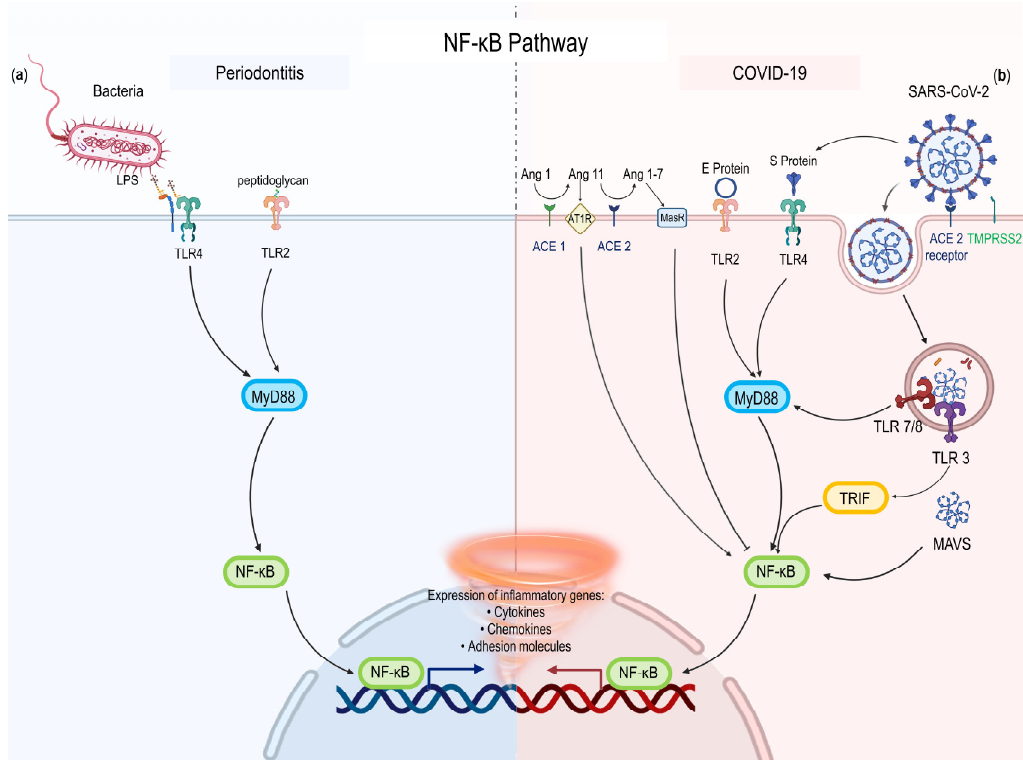
Figure 1. The NF-κB pathway in periodontitis and COVID-19. ( a ) Components of periodontitis pathogens (LPS and peptidoglycan) activate PRRs (TLR2 or TLR4). Then, these receptors activate MyD88/NF-κB pathway. ( b ) SARS-CoV-2 activates NF-κB via TLRs/MyD88/NF-κB and AT1R/NF- κB pathway. Then, the expression of inflammatory genes such as cytokines, chemokines, and adhesion molecules are upregulated. Legend. ACE2, angiotensin receptor 2; Ang, Angiotensin; AT1R, Angiotensin II type 1 receptor; LPS, lipopolysaccharide; MAVS, Mitochondrial Antiviral Signaling Protein; SARS-CoV-2, severe acute respiratory syndrome coronavirus-2; TLR, Toll-like receptor; TMPRSS2, Transmembrane Serine Protease 2.